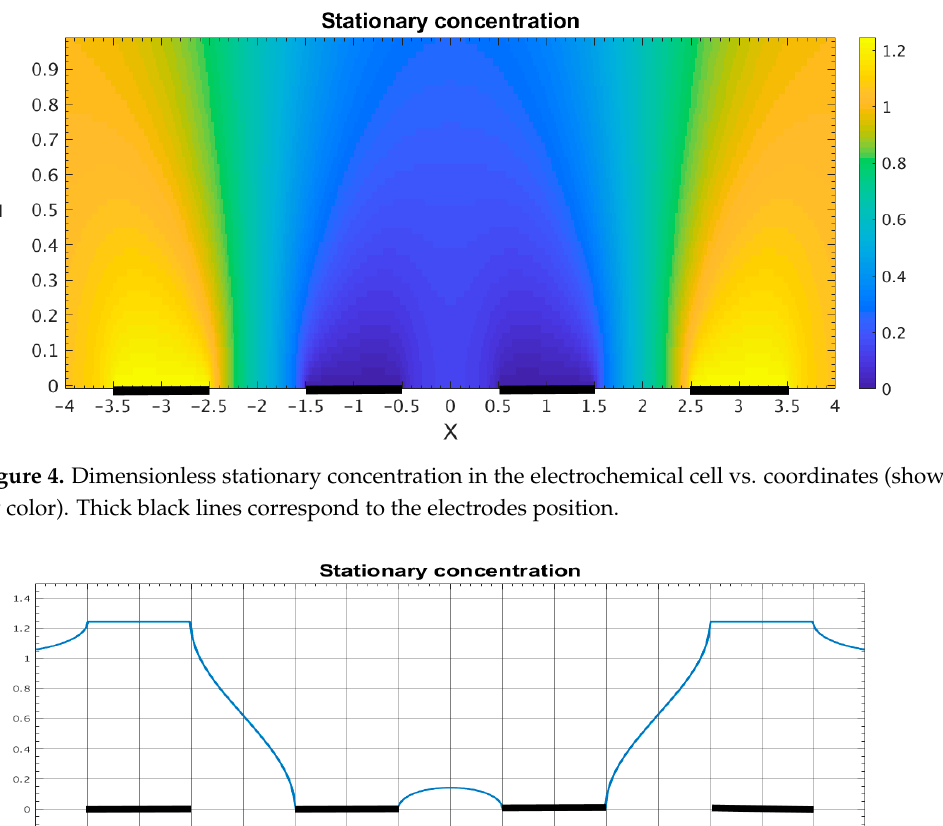
the normal and tangential components of the steady-state concentration gradient. For sev- eral sets of geometries, the corresponding plots are shown in Figure 6 for tangential com- ponents and in Figure 7 for normal components.